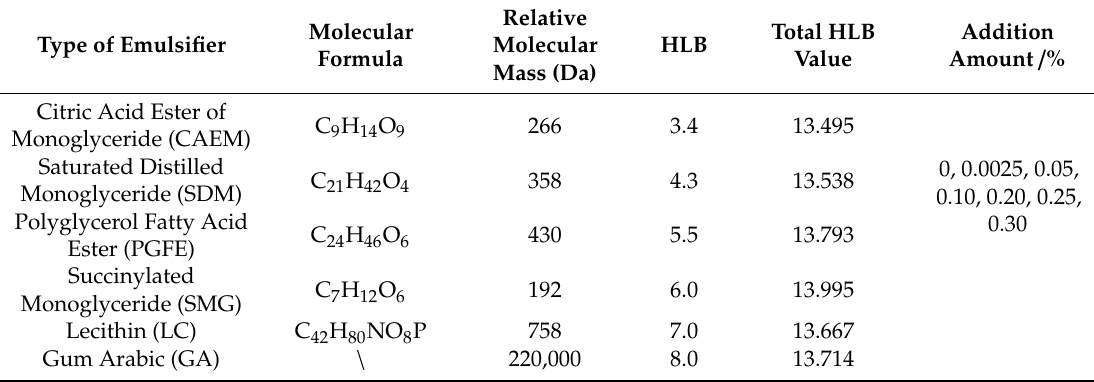
Figure 6. Changes in the particle size of di ff erent emulsifiers in the emulsion during storage. ( A ) The particle size of the di ff erent emulsifiers; ( B ) the optical micrographs of the control and succinylated monoglyceride (SMG)-stabilized emulsion on days 0 and 14. Table 1. The selected amounts of emulsifier